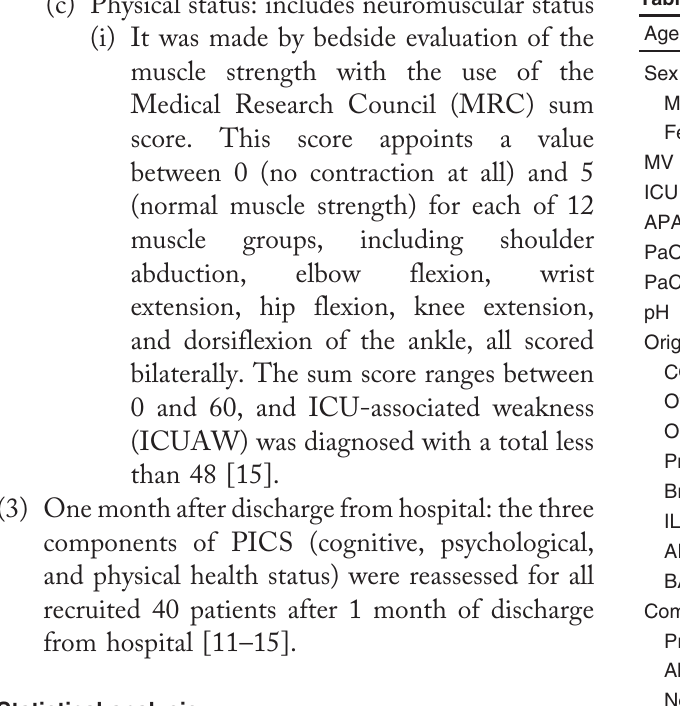
Table 1 General characteristics of the studied